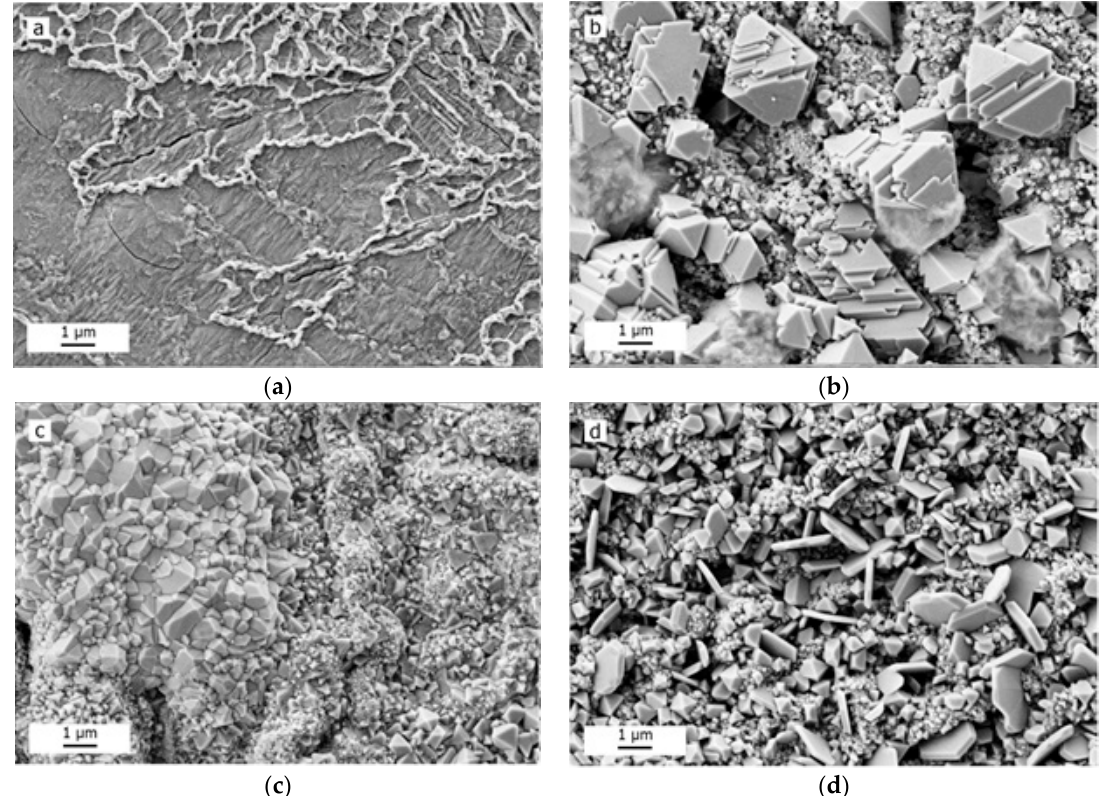
Figure 5. SEM micrographs of the surface of the samples after the oxidation resistance tests: ( a ) 16Mo3 steel, ( b ) pure NiCr, ( c ) NiCr-Re, and ( d ) NiCr-Re-Al 2 O 3 .